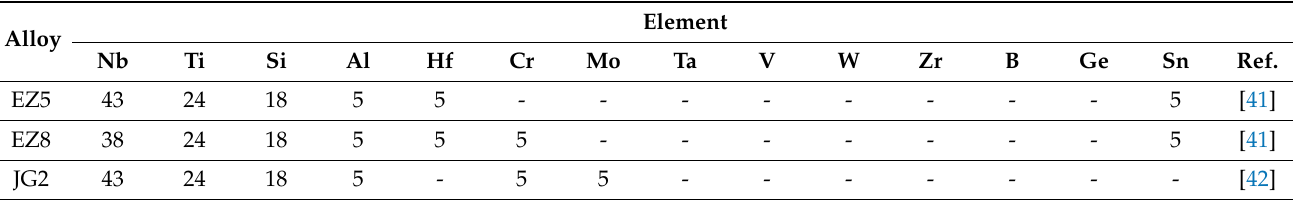
Table A1. Nominal compositions (at.%) of reference alloys used in this